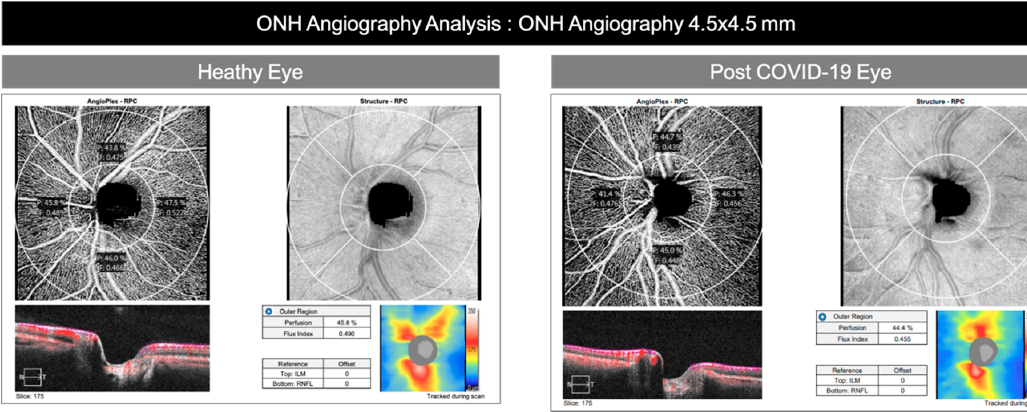
Table 3. Analysis of primary and secondary outcomes in the study groups .